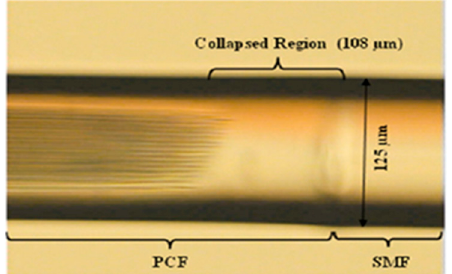
Figure 26. Micrograph of splicing region between PCF and SMF. Using it Mach–Zehnder interferometer is formed for curvature measurement (Reproduced from [92], with the permission of IOP Elsevier publishing).